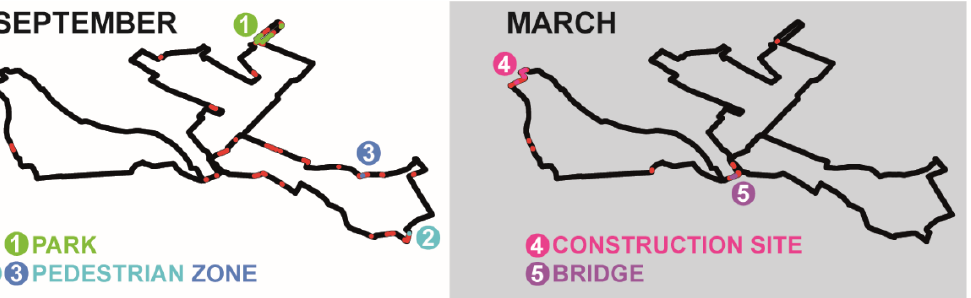
Figure 6. Locations with 10% highest PM 2.5 concentrations in >60% of all runs in September ( left panel) and March ( right panel). Colors refer to parks (green), pedestrian zone (blue and cyan), construction site (magenta), and a bridge (violet).